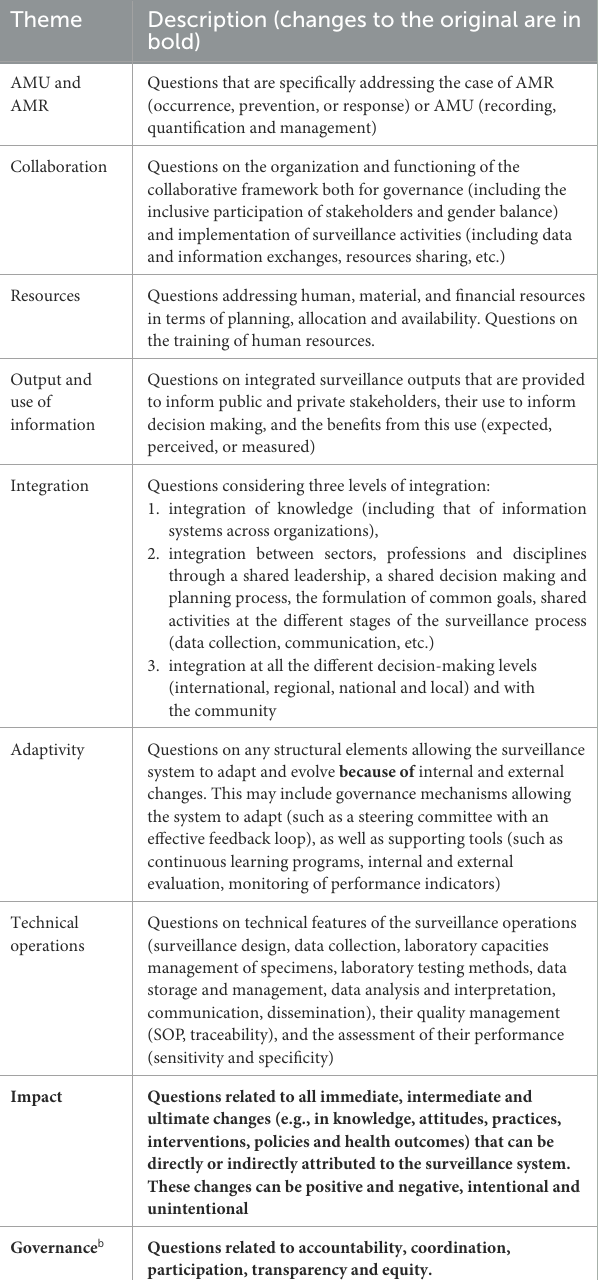
TABLE 2 Updated description of nine content themes a . TABLE 3 Description of the four questions used for the SWOT-like approach, divided into the original and updated